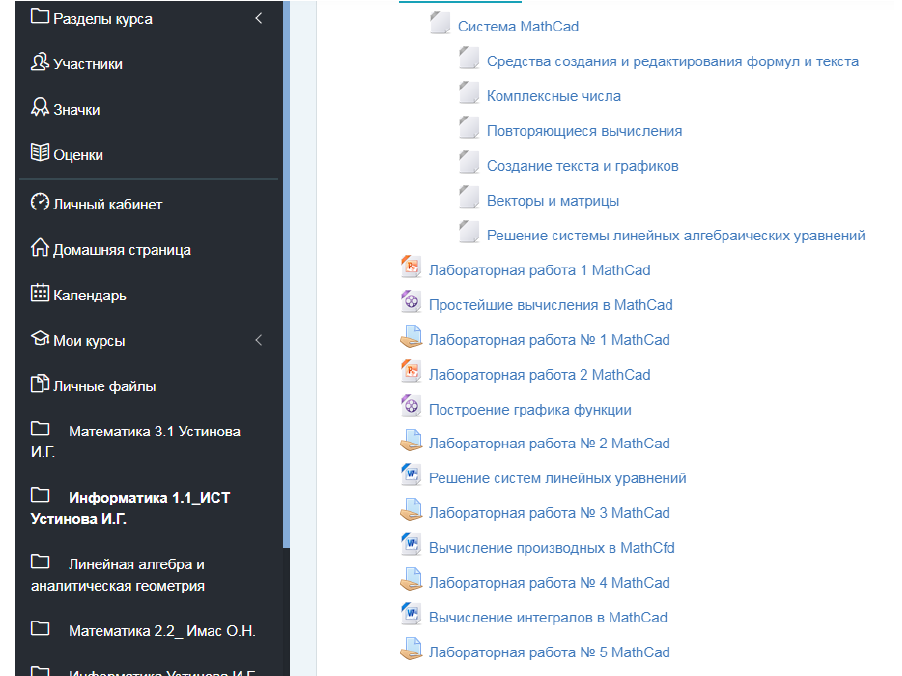
Fig. 1. Part of the electronic resource on the MOODLE platform, designed to study